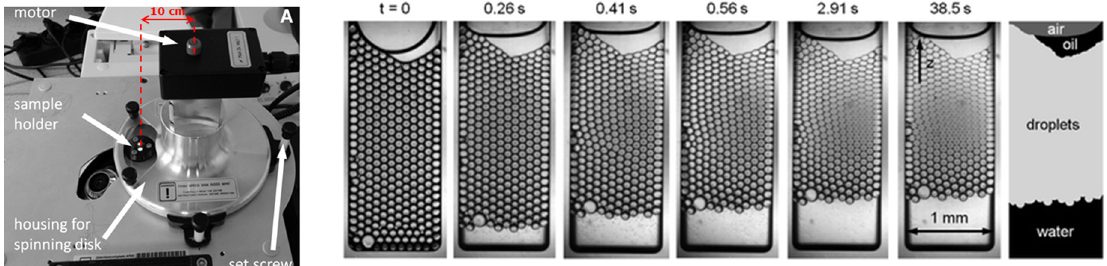
Figure 10. Left: Picture of the experimental setup with the microfluidic chip on the centrifuge. Right: Series of images recorded during a compression experiment with a relative g-force a/g = 231, with a the radial acceleration and g = 9.81 m s − 1 the normal gravitational acceleration. The enhanced gravity force acts along the z-direction. The emulsion is a hexadecane-in-water emulsion stabilized by 10 mM SDS. The droplet diameter is 97 µ m. Upon centrifugation, the droplet layer is compressed, and a layer of pure aqueous phase forms at the bottom of the sample chamber, as displayed in the scheme on the right. After 2.91 s, a steady-state height of the droplet column is reached (reproduced from [91], with permission from The Royal Society of Chemistry).